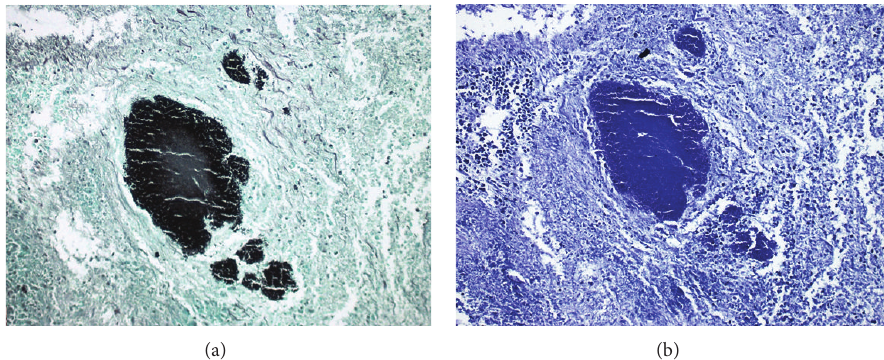
Figure 3: Microscopic appearance of colonies of Actinomyces with periodic acid-Schiff and Grocott’s dye ( × 40).